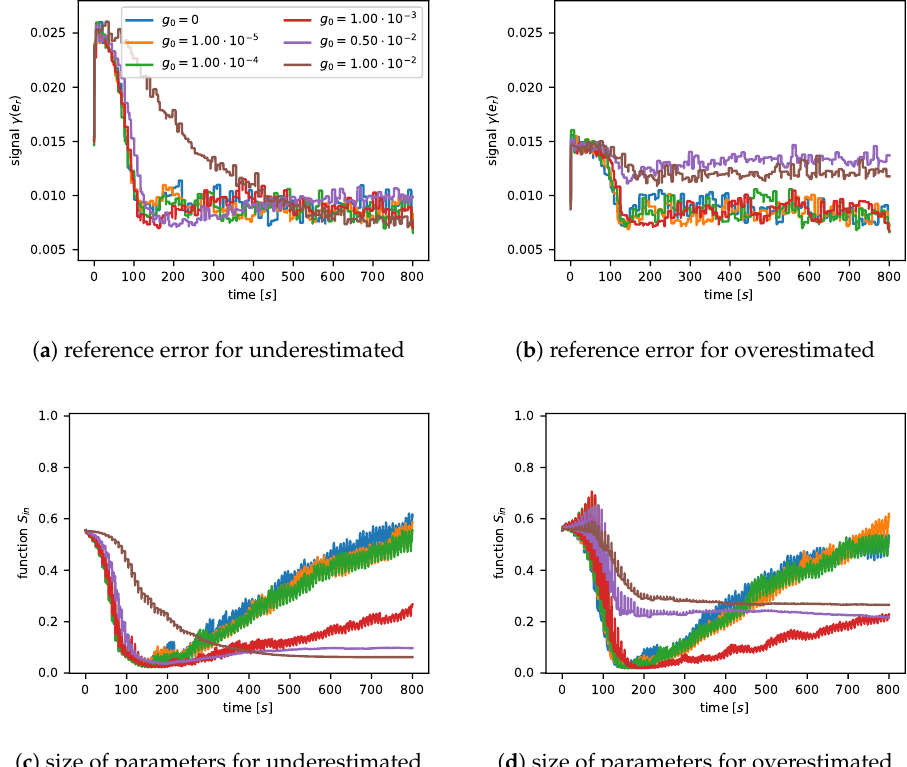
Figure 5. The transients of the control process for various values of g 0 ( g 0 equal to 0 with no dead